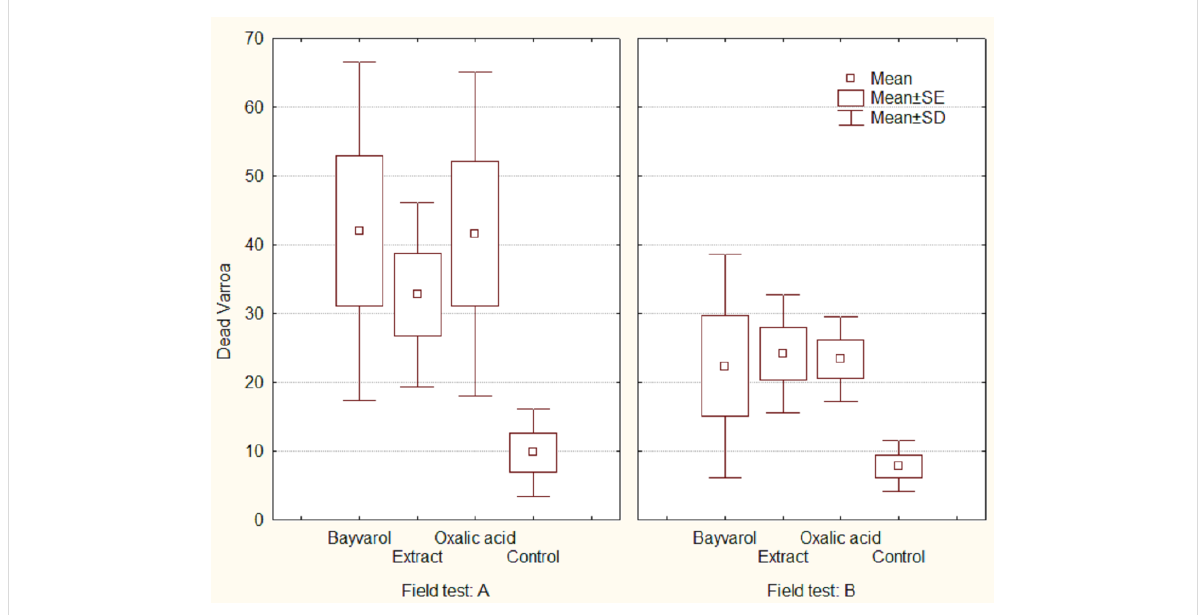
Figure 3: Field test results on application of extract B, bayvarol and oxalic acid to bee populations.